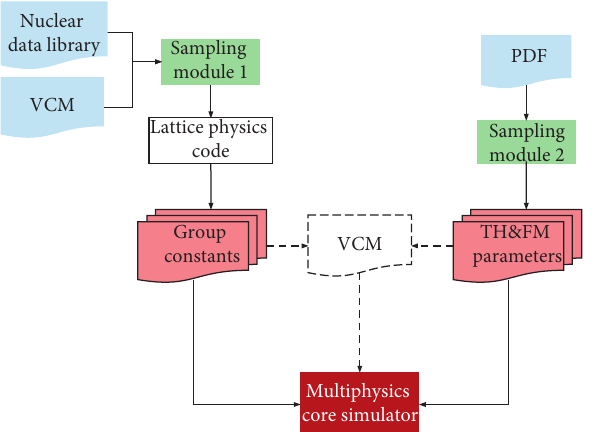
Figure 16: Uncertainty propagation methodology for coupled multiphysics